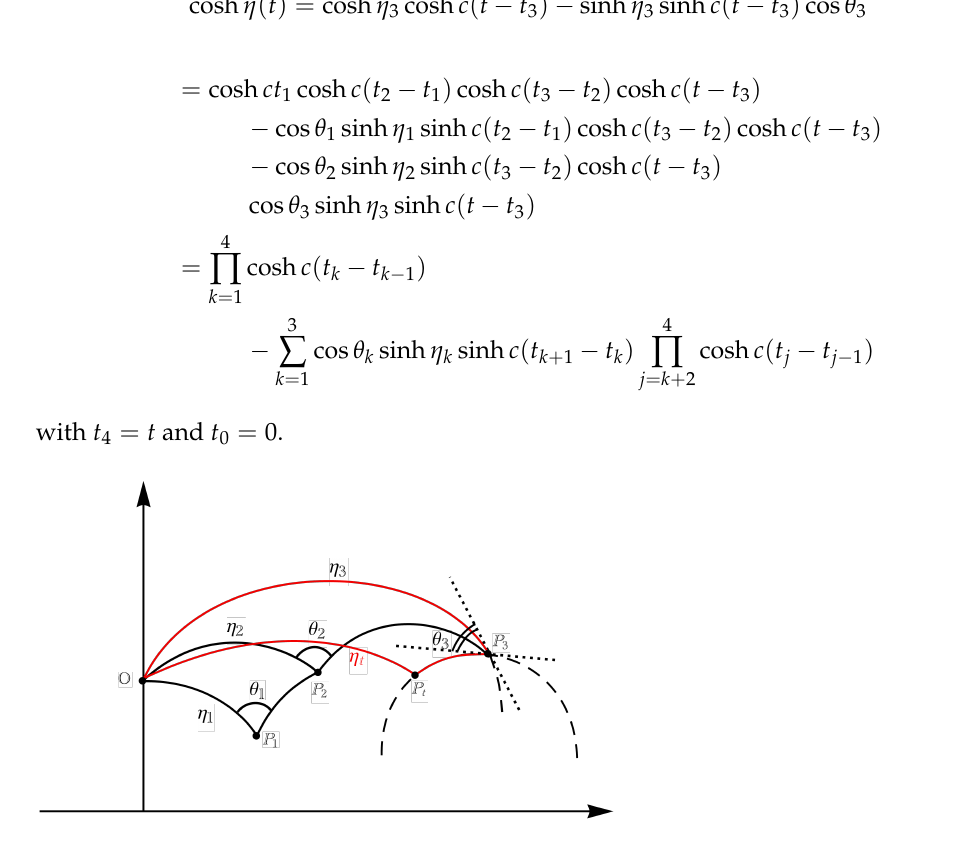
Figure 5. Distance travelled after the third Poisson